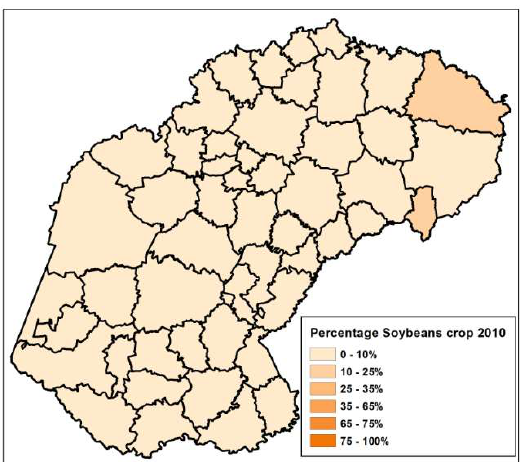
Figure 8. Calculated percentage of maize from other cultivated crops in 2014